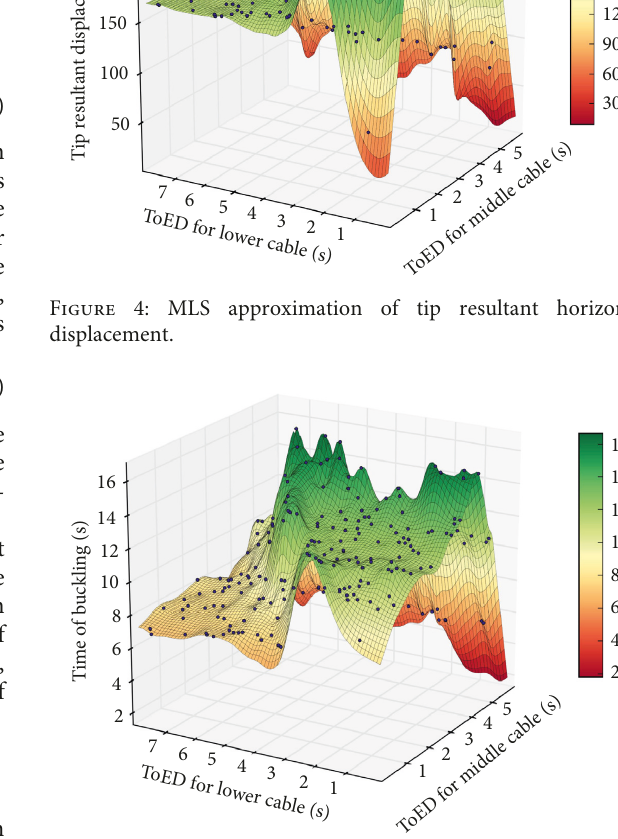
Figure 5: MLS approximation of time of first buckling.